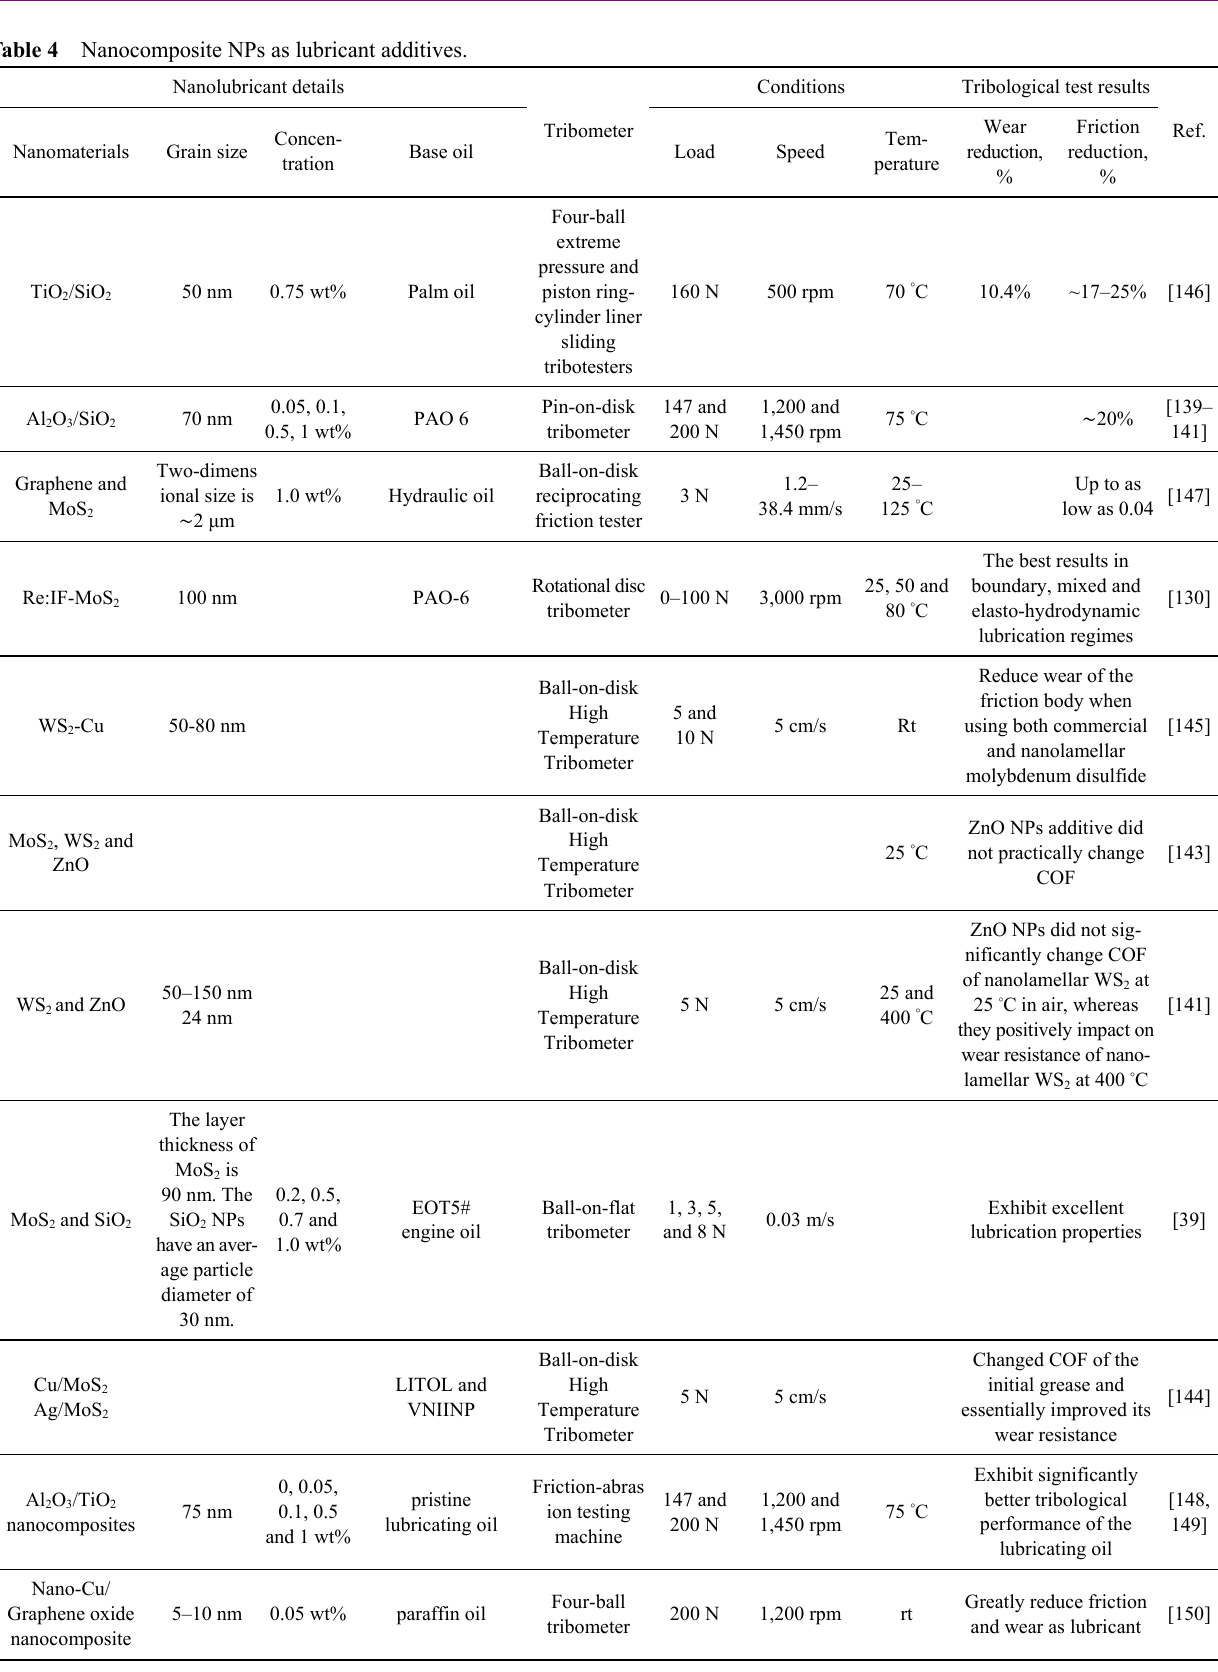
Table 4 Nanocomposite NPs as lubricant